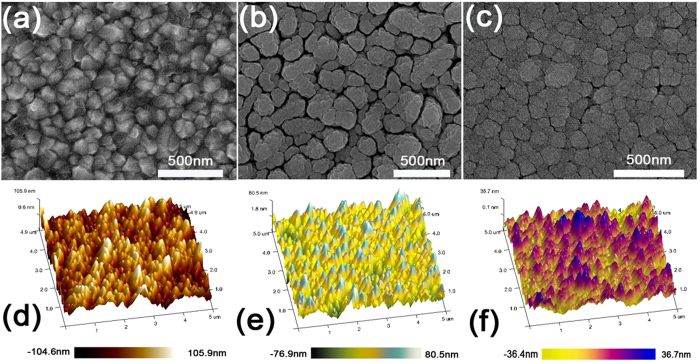
(a) and (d) show the SEM and AFM images of a bare FTO surface respectively. (b,e) show the SEM and AFM images of the surface of TiO2 on FTO with 15 min deposition respectively (c,f) show the SEM and AFM images of the surface of TiO2 on FTO with 30 min deposition respectively.